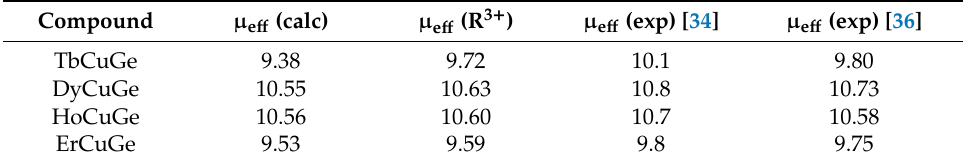
Table 2. Calculated e ff ective magnetic moment µ e ff (calc) of rare-earth ions, theoretical magnetic moments µ e ff (R 3 + )calculatedforR 3 + , experimentalvaluesofthee ff ectivemagneticmomentfrom[34,36]. All values are in µ B